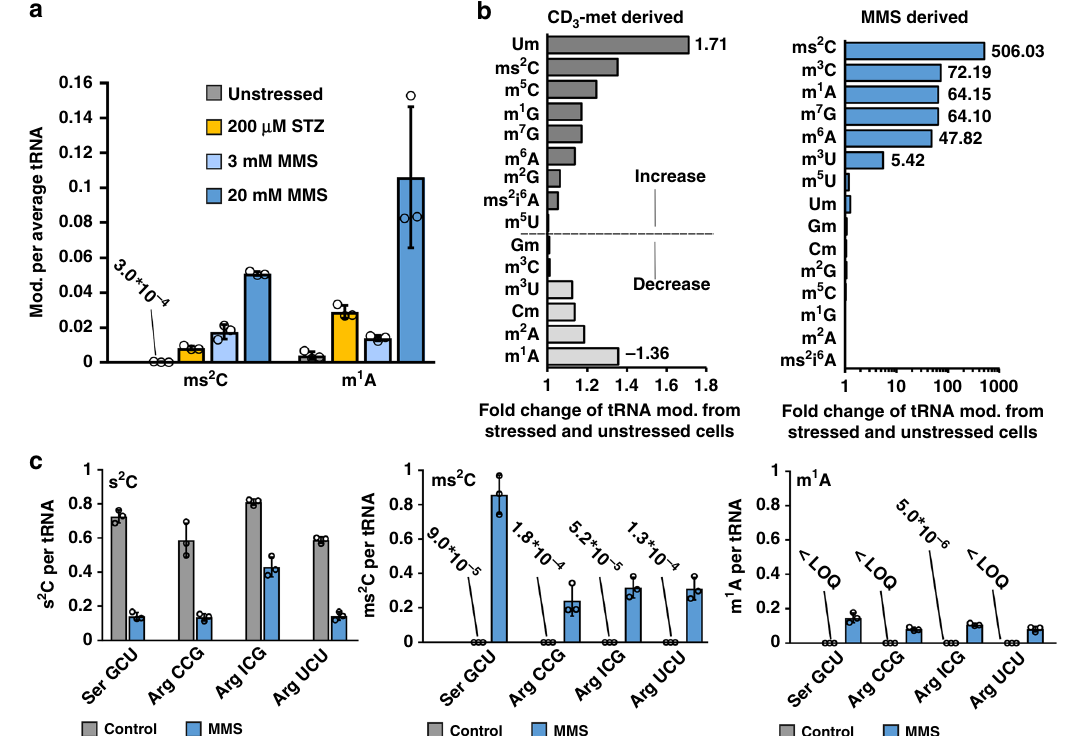
Fig. 2 Absolute abundance of modi fi ed nucleosides in total tRNA and tRNA isoacceptors after methylation stress. a Abundance of mod. (ms 2 C and m 1 A) per average tRNA after 0 mM (unstressed, gray), 200 µ M Streptozotocin (STZ, natural methylating agent, 50% lethality, orange), 3 mM MMS (no lethality, light blue) and 20 mM MMS (50% lethality, dark blue). b Impact of MMS exposure (unstressed vs. 20 mM stressed) on E. coli total tRNA modi fi cations (mod.). The origin of the methylated tRNA modi fi cations is displayed in separate plots. Left: impact of MMS exposure on CD 3 -met (met = methionine) derived methylation displayed as the fold change ratio of stressed-to-unstressed. Right: impact of MMS exposure on directly methylated nucleosides (MMS derived methylation) displayed as the fold change of stressed-to-unstressed. c Absolute abundance of s 2 C (left), ms 2 C (middle) and m 1 A (right) in various tRNA isoacceptors without (gray) and with (blue) 20 mM MMS exposure. In the negative control (without MMS) E. coli were grown in 13 C medium (gray bars, control) and the MMS exposed bacteria in non-labeled (blue bars, MMS) media. Co-puri fi cation of tRNA isoacceptors was done in a comparative NAIL-MS experiment as detailed in the text. All experiments are from n = 3 biol. replicates and error bars re fl ect standard deviation. Source data are provided as a Source Data fi